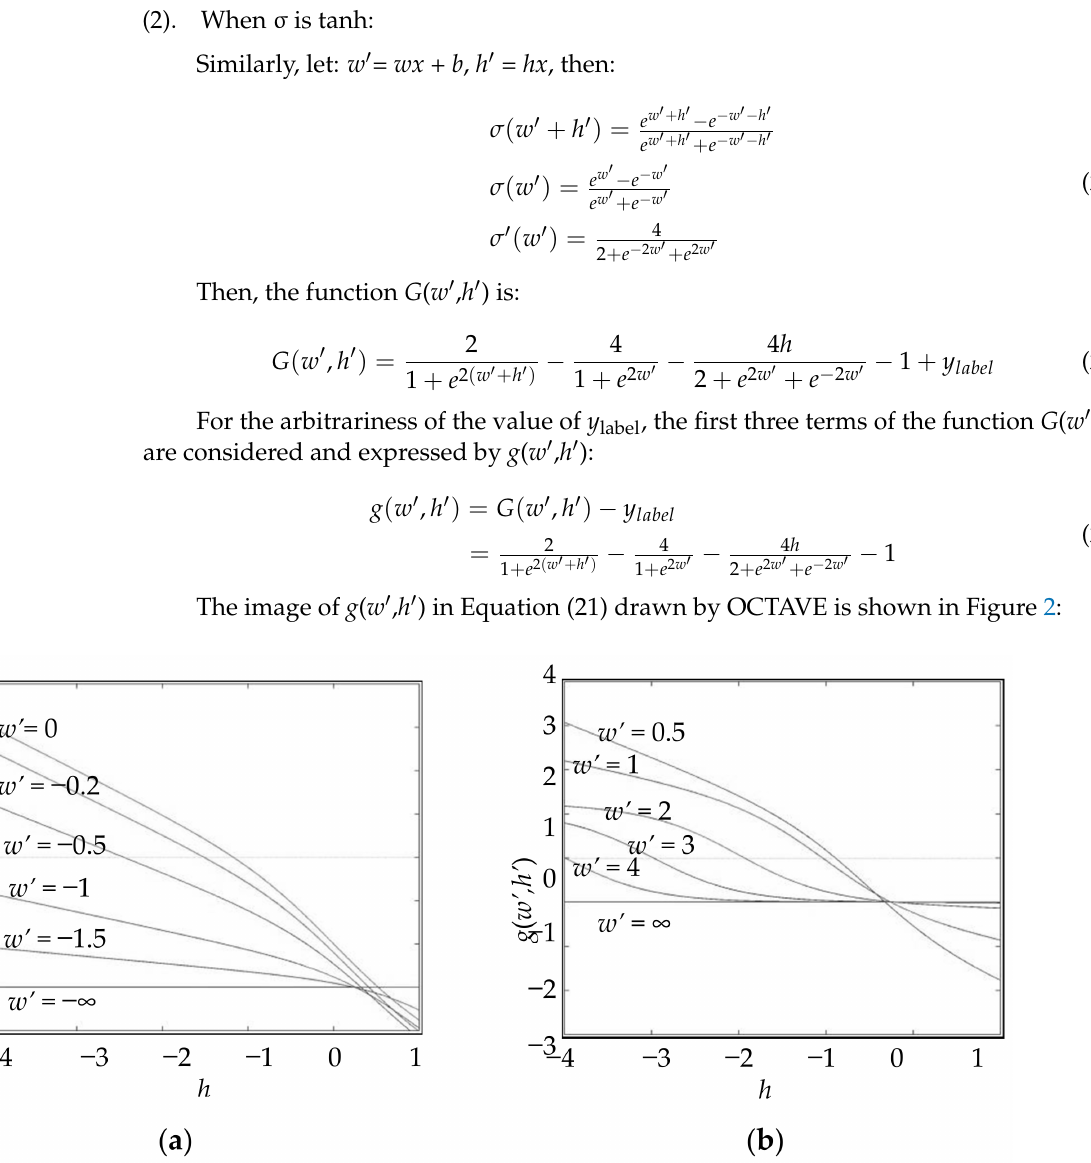
g ( w (cid:48) , h (cid:48) ) = − 3; w → ∞